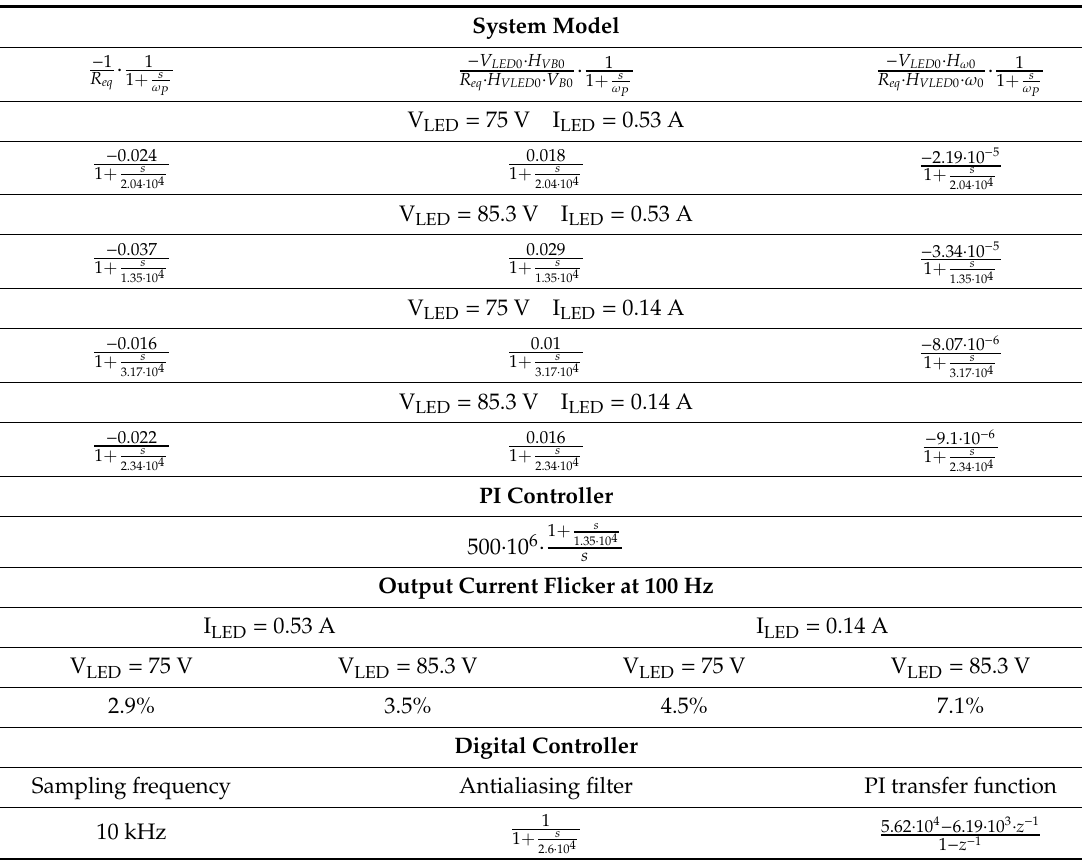
Table 2. Controller